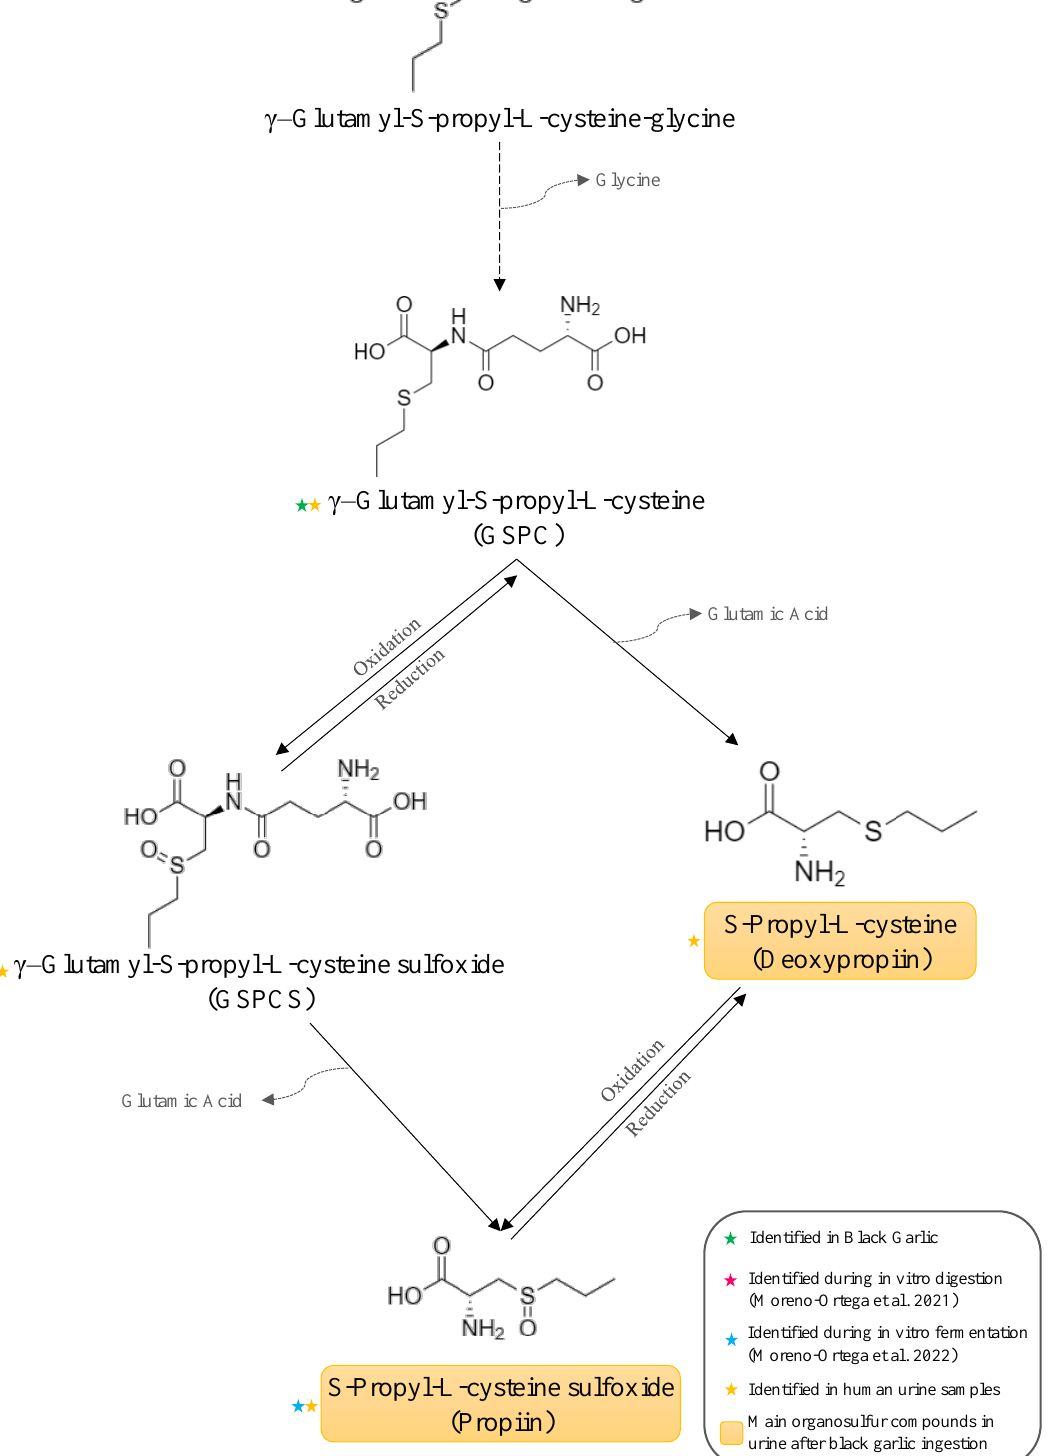
Figure 6. Degradation pathway proposed for γ-glutamyl- S -propyl cysteine-glycine. Boxes with compounds indicate the main components excreted in urine after black garlic intake.